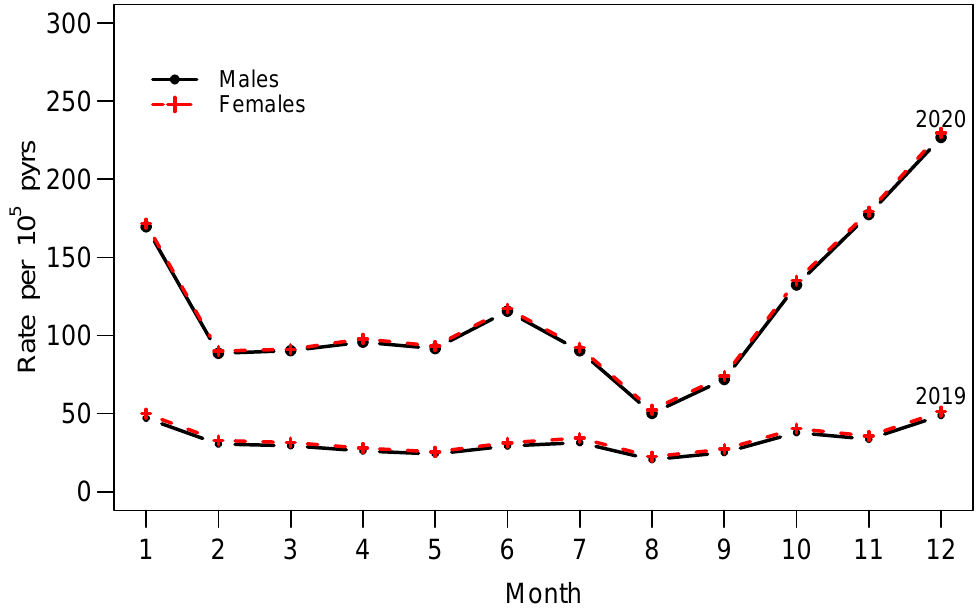
Figure 3. Incidence rate of malaria among children under five years old per 100,000